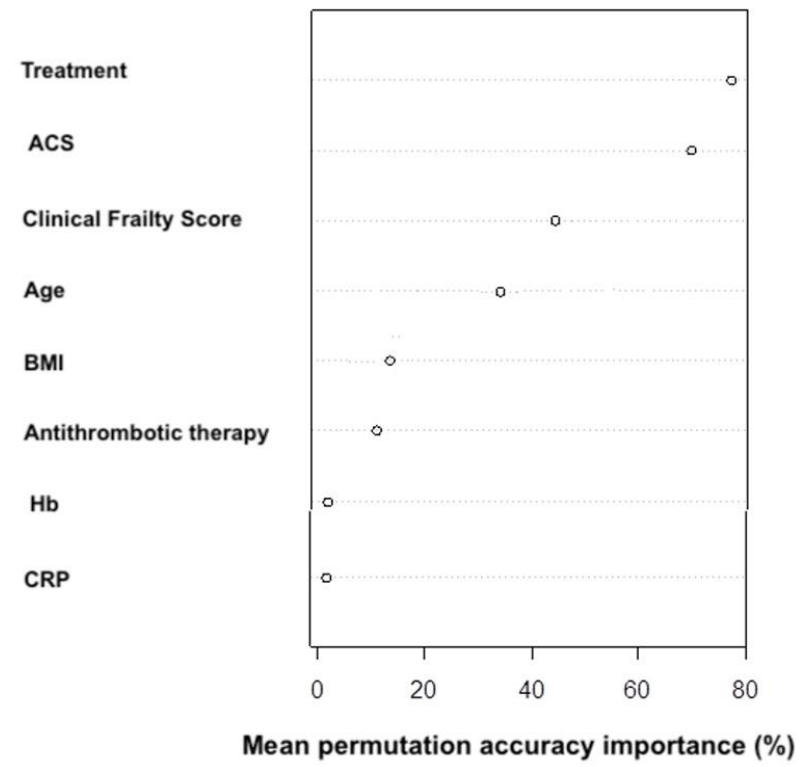
Figure 1. Variable importance estimated by permutation-based mean decreased accuracy importance considering adverse event rate as outcome.